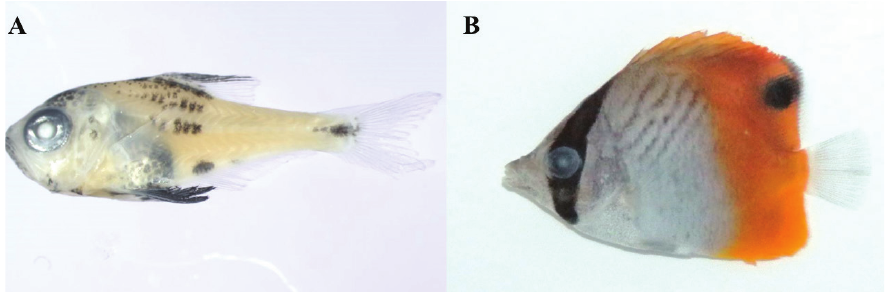
Figure 7. A Pempheris japonica , MFD-894, 10.8 mm SL B Chaetodon auriga , MFD-778, 25.7 mm SL.